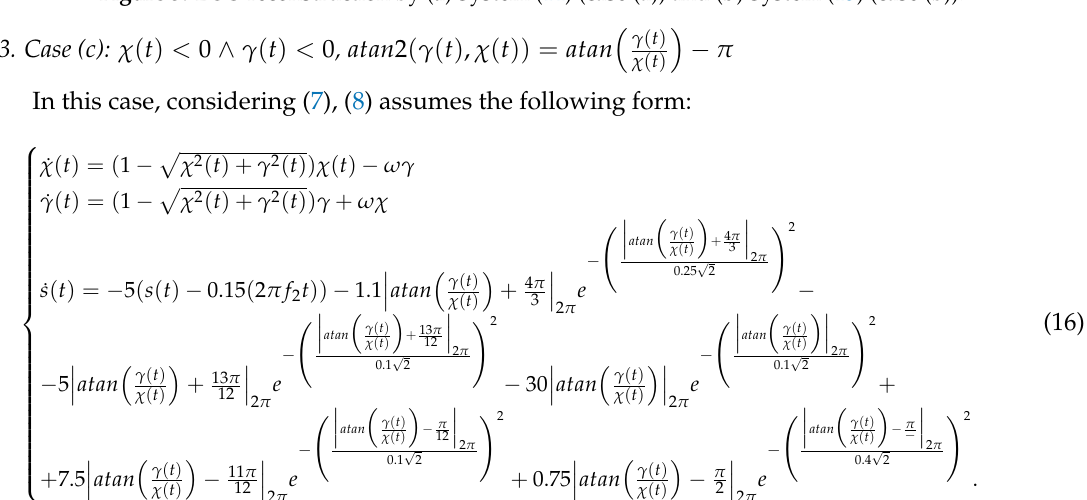
Figure 3. ECG reconstruction by ( a ) System (14) (case (a)) and ( b ) System (15) (case (b)).